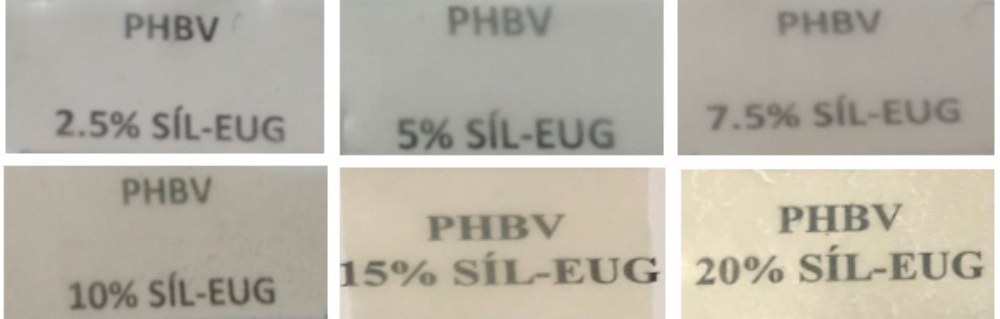
Figure 5. Visual aspect of the electrospun films of poly(3-hydroxybutyrate- co -3-hydroxyvalerate) (PHBV)/Mobil Composition of Matter (MCM)-41 with eugenol.